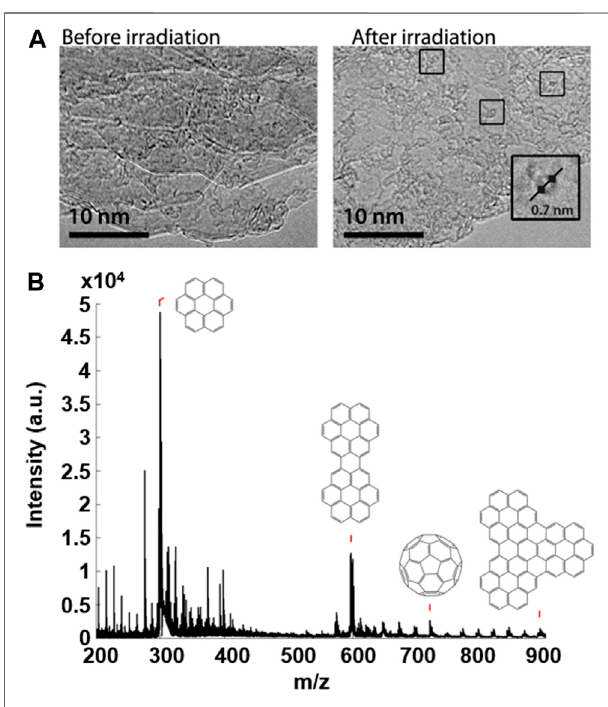
FIGURE 5 | TEM micrographs (A) of a sample of coronene before and after laser irradiation using MALDI-TOF MS. Boxes highlight fullerene structures seen following laser irradiation along with a magni fi ed example illustrating the diameter of the structure (0.7 ± 0.1 nm). The mass spectrum resulting from the UV irradiation of the sample (B) shows the oligomer structures assigned to major peaks, along with the detection of C 60